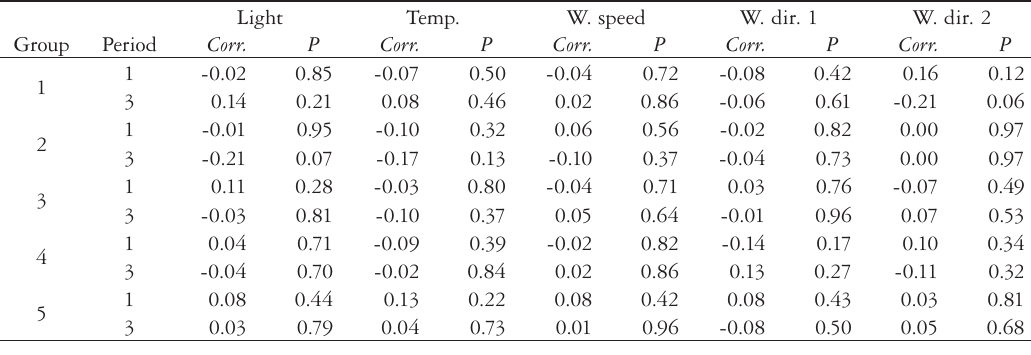
Table 2. Pearson’s correlation (Corr.) and probability values ( P ) between the feeding behavior for each group and the environmental variables solar radiation (light), temperature (temp.), wind speed (W. speed), and wind direction (W. dir. 1 is wind direction different than from the north and W. dir. 2 is wind direction different than that from the west) during periods 1 and 3.